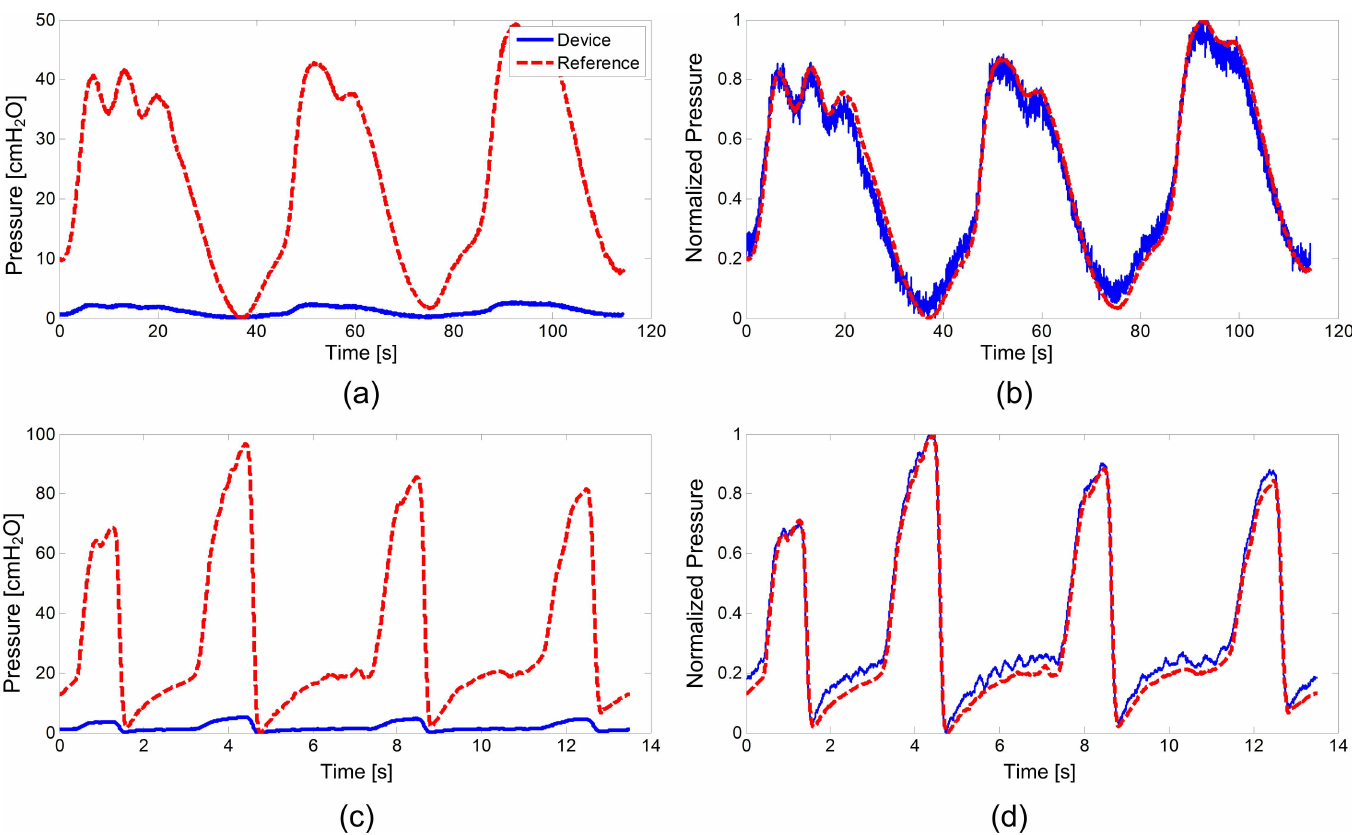
Fig 2. Feline Contraction Recordings. Examplesof device (solid blue line) and reference (dashedred line) recordingsof (a) bladderpressure as-recorded and (b) normalized contractions inducedby electrical stimulation in the feline and (c) bladder pressureas-recordedand (d) normalized fast pressure changes due to manualbladdercompressionin the felineshowinga faster rise time and slower decrease in pressures measuredby the device.